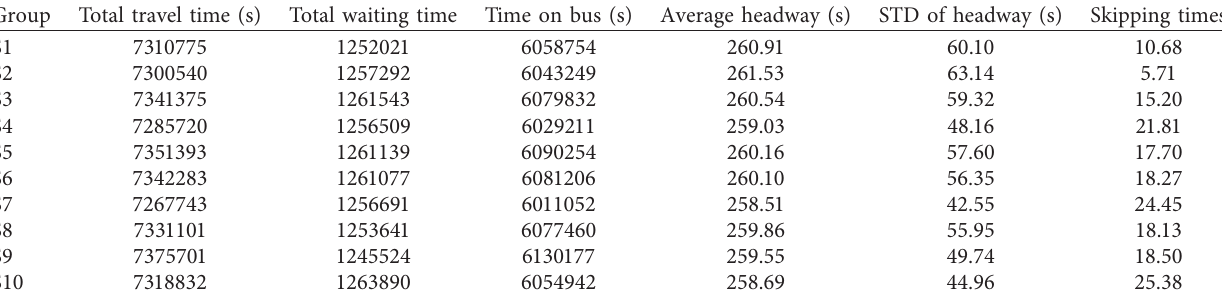
Table 2: The performance indices under variable number of CPS.